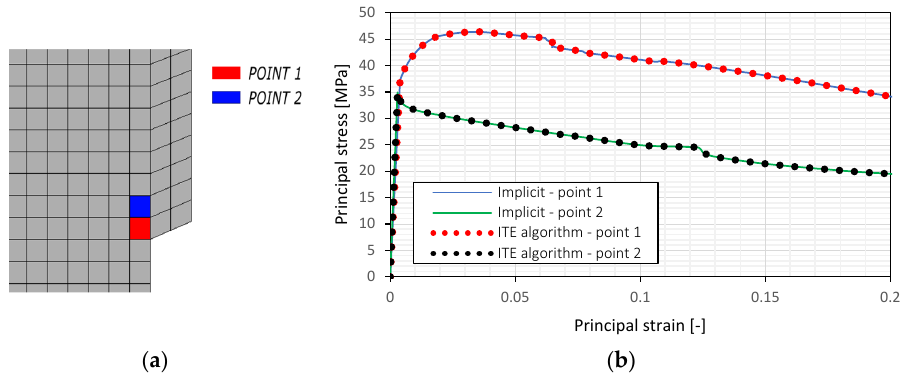
Figure 11. Vertical load vs. CMOD for implicit and ITE for the three-point bending beam.